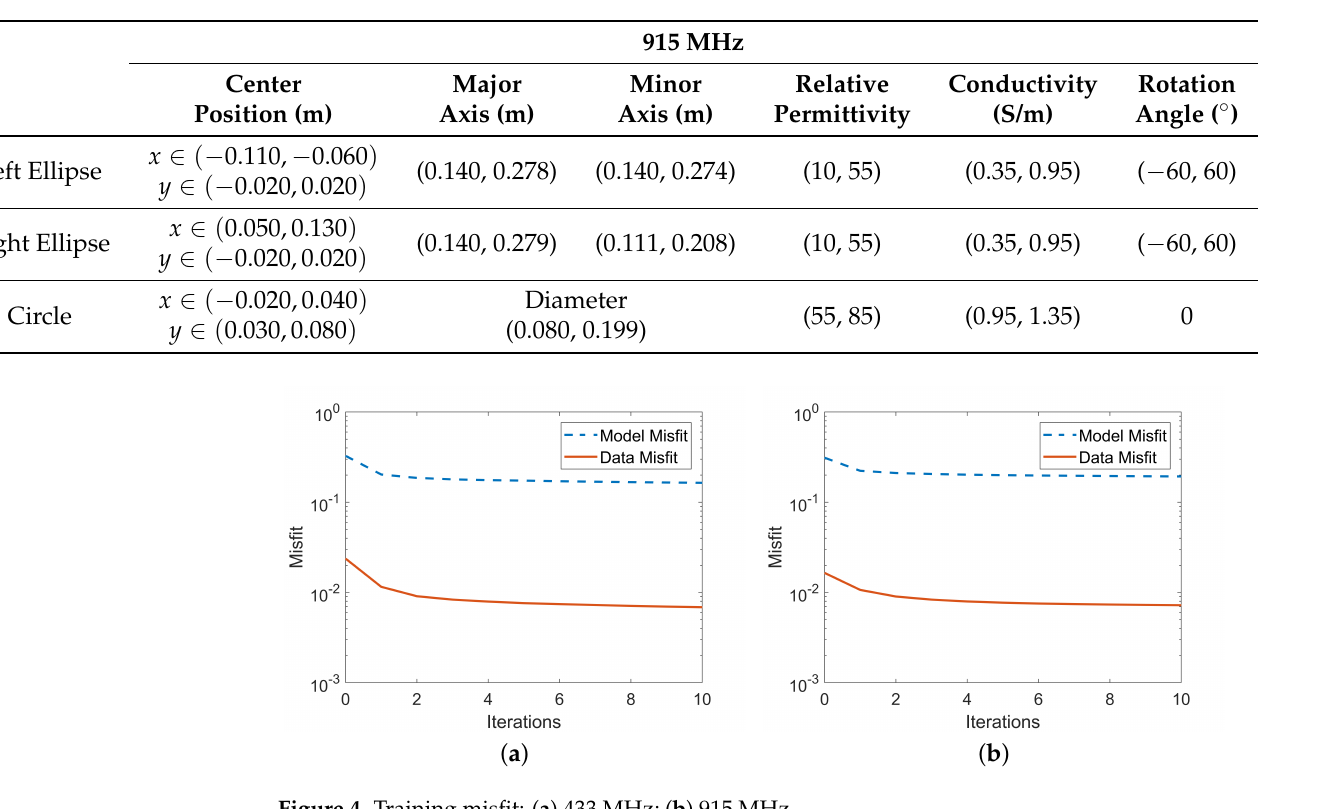
Figure 4. Training misfit: ( a ) 433 MHz; ( b ) 915